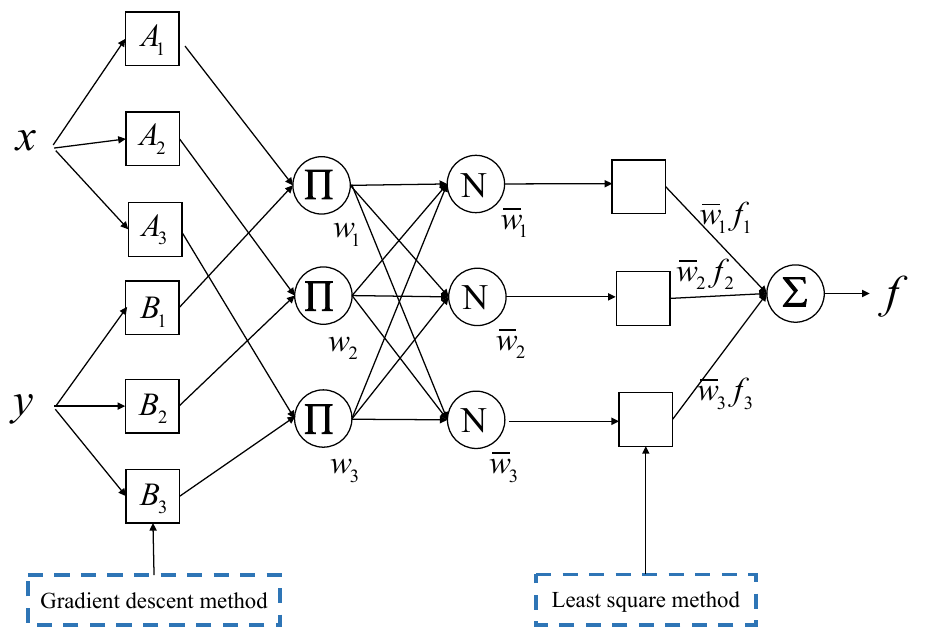
Figure 5. Diagram of the ANFIS